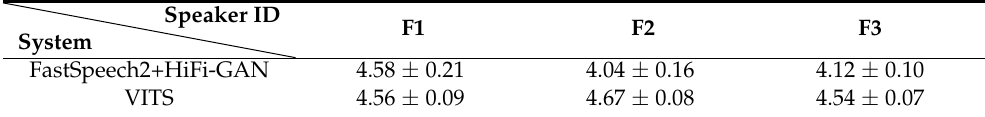
Table 3. Speaker Similarity Mean Opinion Score (SS-MOS) results for the FastSpeech2+HiFi-GAN system with 95% confidence